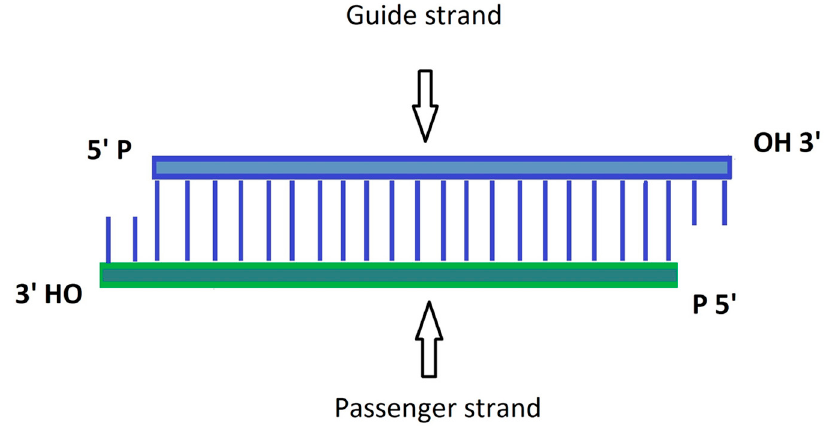
Figure 1. Schematic representation of siRNA